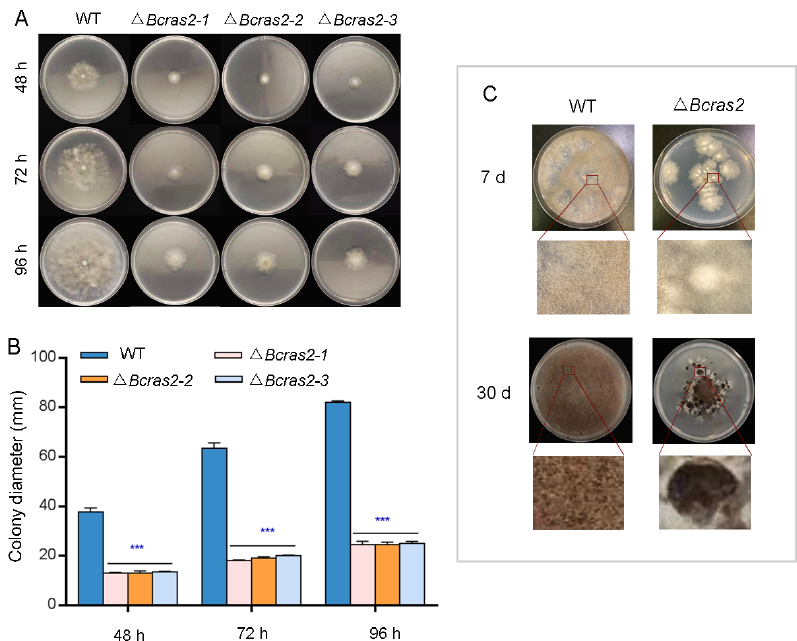
Figure 2. Phenotype detection of Δ Bcras2 mutants: ( A ) Colony morphology of Δ Bcras2 mutants and the wild-type on complete medium (CM) plates. ( B ) Statistical analysis of colony diameter. ( C ) Colony morphology of ∆ Bcras2 mutants and the wild-type on potato dextrose agar (PDA) plates. Strains were cultured at 25 ◦ C. Phenotype detection experiments were repeated three times with similar results, and the pictures shown are representative. Bars represent standard deviations (SD) of means from three CM plates. *** indicate significant differences ( p < 0.001).